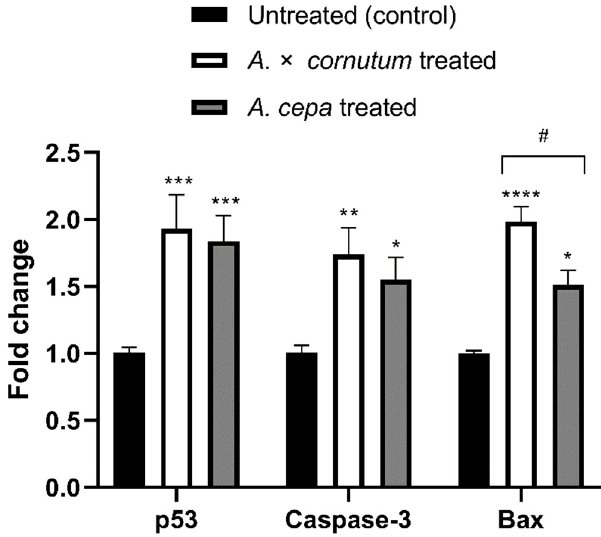
Figure 4. Effects of A. cornutum and A. cepa L. extracts on p53, Caspase-3, and Bax mRNA expression in treated HeLa cells. The relative quantification was performed by delta delta Ct method, and the levels of gene expression were normalized with GAPDH housekeeping gene. The statistical significance was assessed by two-way ANOVA, followed by Dunnett’s multiple-comparisons test. Columns with bars represent mean ± SD, and significant levels compared to control are marked as * p < 0.05; ** p < 0.01, *** p < 0.001, and **** p < 0.0001 (Data S5); significant levels compared to A. cornutum with A. cepa are marked as # p < 0.05 (Data S6).